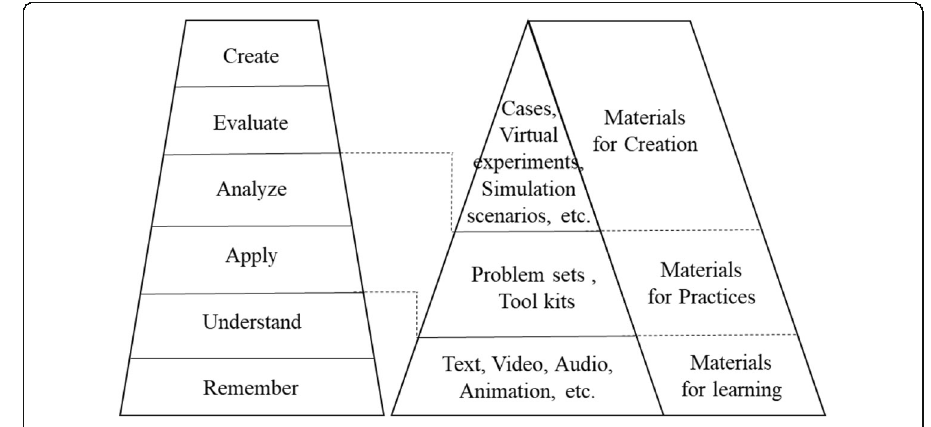
Fig. 6 The hierarchical structure of learning